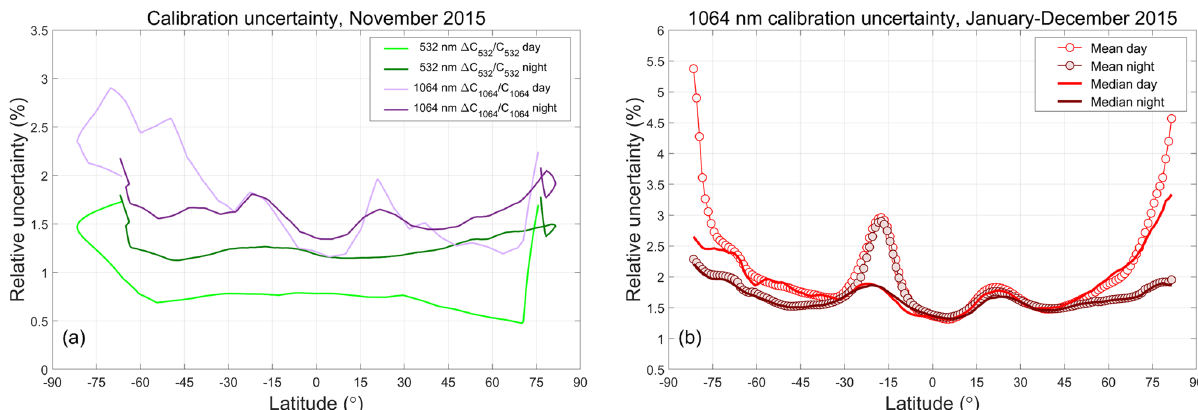
Figure 17. (a) Mean relative calibration coefficient uncertainties, daytime and nighttime, at 532nm (greens) and 1064nm (purples) for November 2015; (b) mean and median relative calibration uncertainties at 1064nm for all data acquired during 2015. In (b) , the large excursion in the mean uncertainties at ∼ 20 ◦ S is due to increased uncertainties in the 532nm calibration coefficients due to high radiation noise in the SAA (Hunt et al., 2009; Noel et al.,